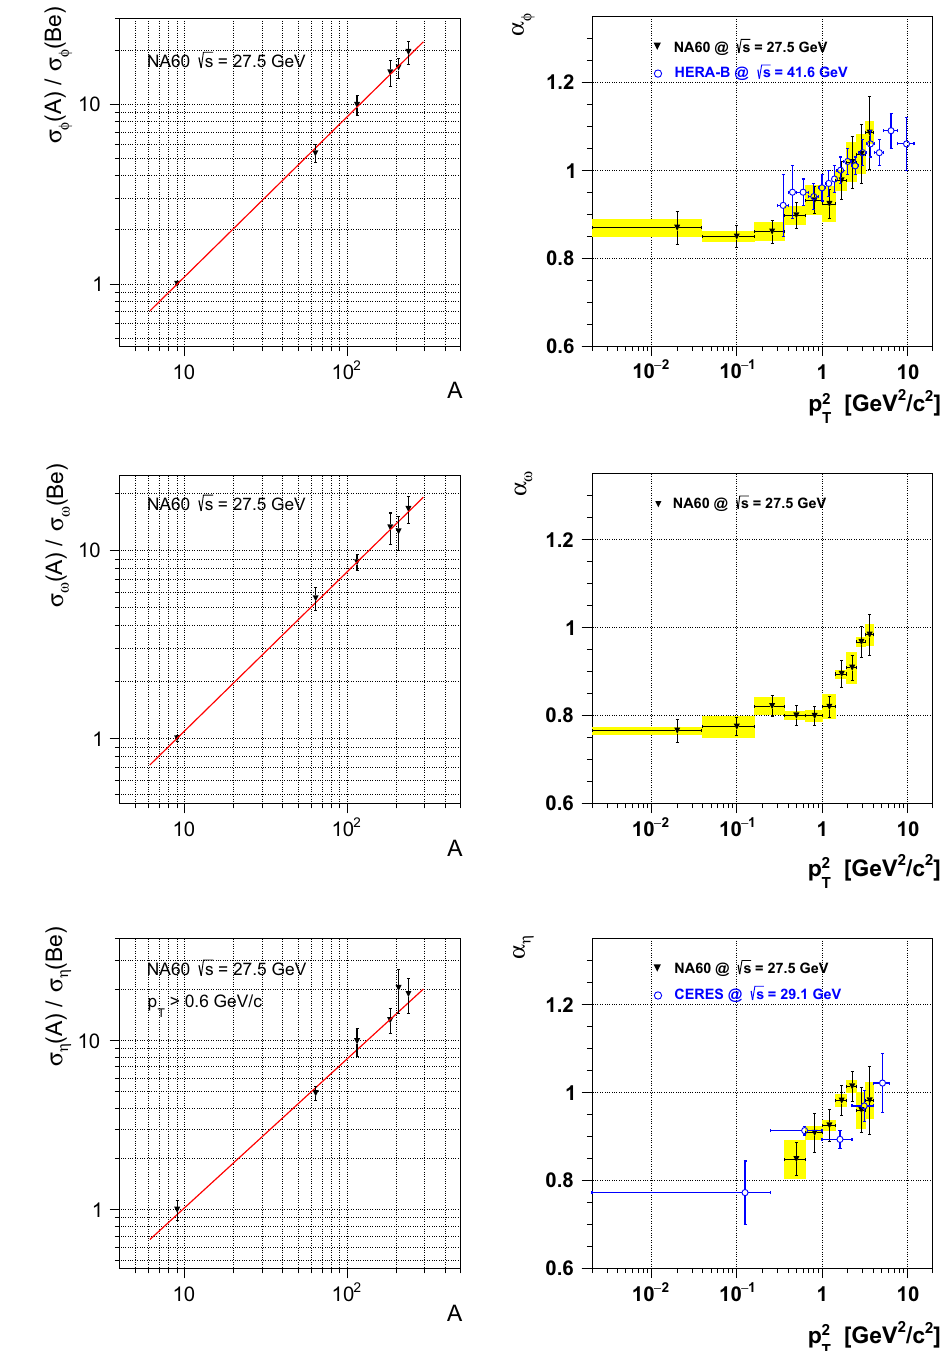
Fig. 5 Left column: fit on the relative production cross sections for the ω , φ and η mesons as a function of A, normalized to the Be or the Cu target. Right column: p T dependence of the α parameter for the ω , φ and η